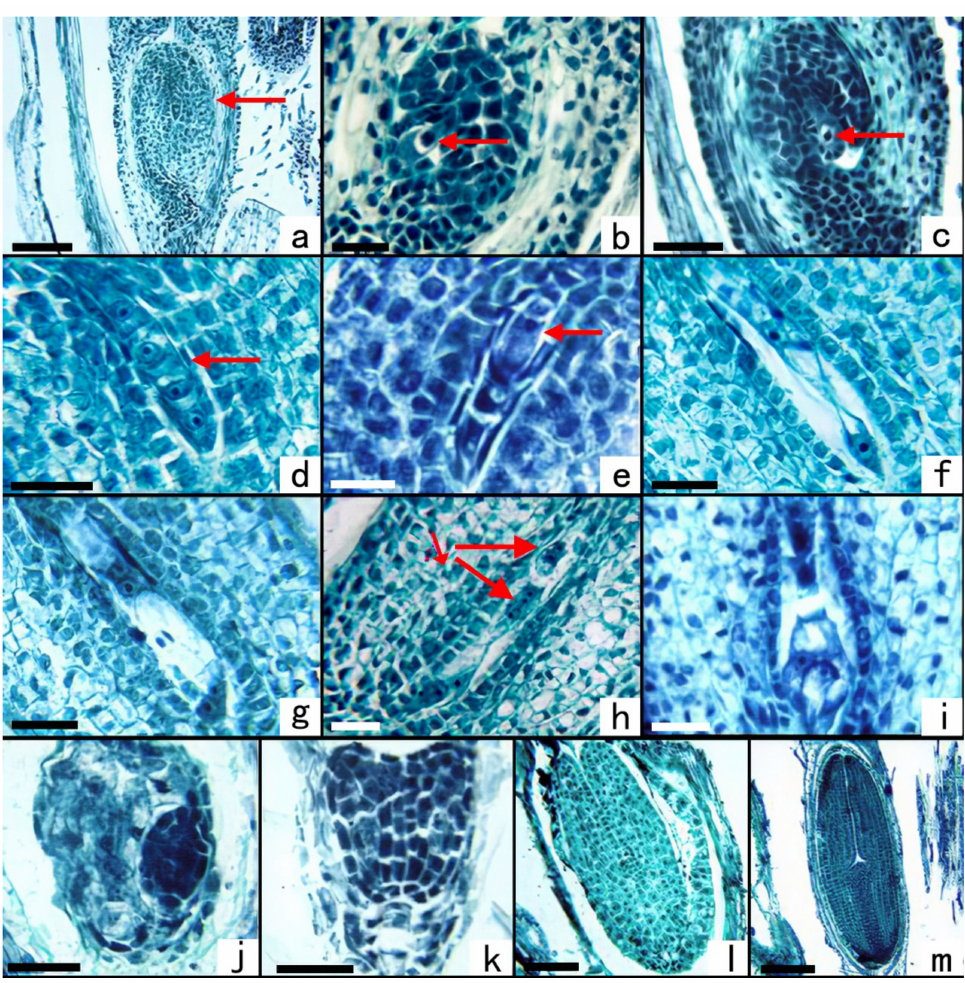
Figure 4. Megasporogenesis, female gametophyte, and embryonic development of S. canadensis (population number: CN04). Section stained with hematoxylin-Fast Green FCF. ( a ) Anatropous ovule. ( b ) Archesporial cell. ( c ) Megasporocyte. ( d ) Linear megaspore tetrad. ( e ) The megaspore at the chalazal end became a functional megaspore and developed into a one-nucleate embryo sac. ( f ) Two-nucleate embryo sac. ( g ) Four-nucleate embryo sac. ( h ) Eight-nucleate embryo sac, showing one synergid, one egg cell, one polar nuclear, and two multinucleated antipodal cells arrayed in tandem. ( i ) Mature embryo sac. ( j ) Globular embryo. ( k ) Heart-shaped embryo. ( l ) Torpedo-shaped embryo. ( m ) Mature embryo A: antipodal cells. Scale bars: a = 100 µ m, b = 25 µ m, c = 50 µ m, d–h = 25 µ m, i–j = 50 µ m, k–m = 100 µ